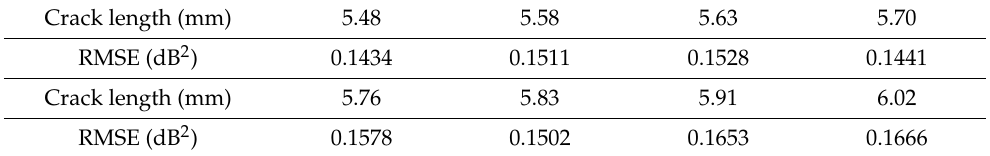
Figure 7. Calculations of non ‐ uniform strains of FBG1 based on the DIC method. Table 2. Strain reconstruction accuracy of experimental FBG reflection spectra by GWO